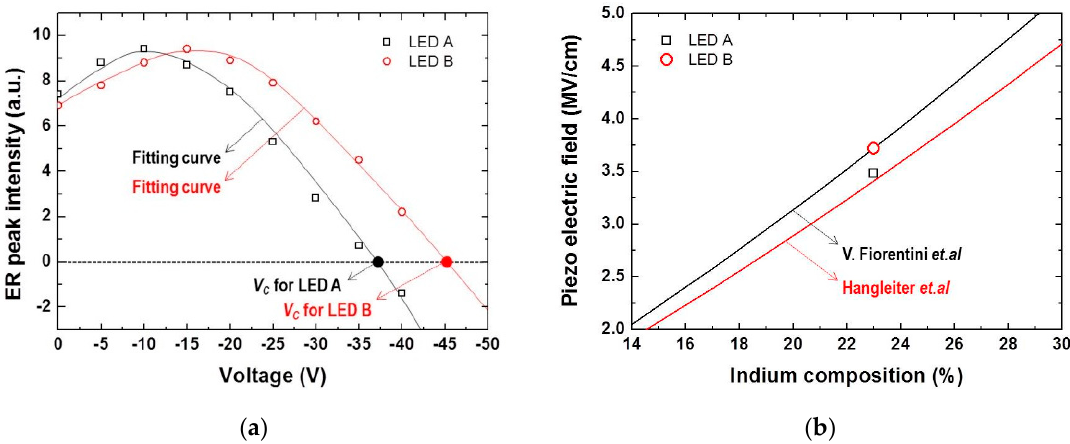
Figure 2. ( a ) The peak intensity of the ER spectra and the fitting curves plotted against the applied reverse bias for LED A and LED B. ( b ) Measured piezoelectric field values (dots) and the theoretically calculated values (solid lines).